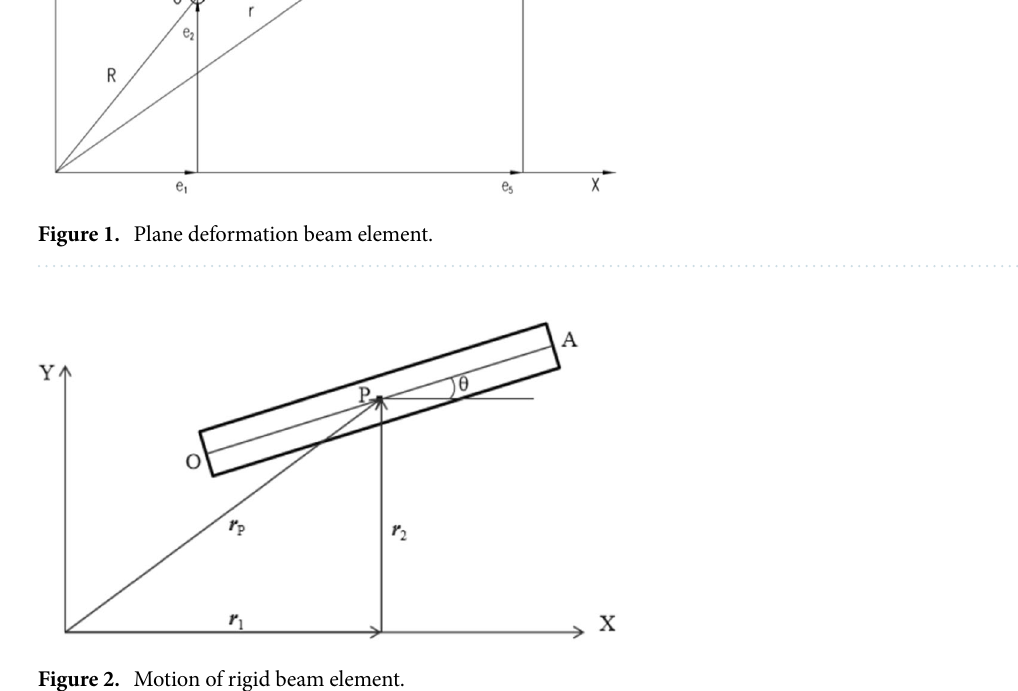
Figure 2. Motion of rigid beam